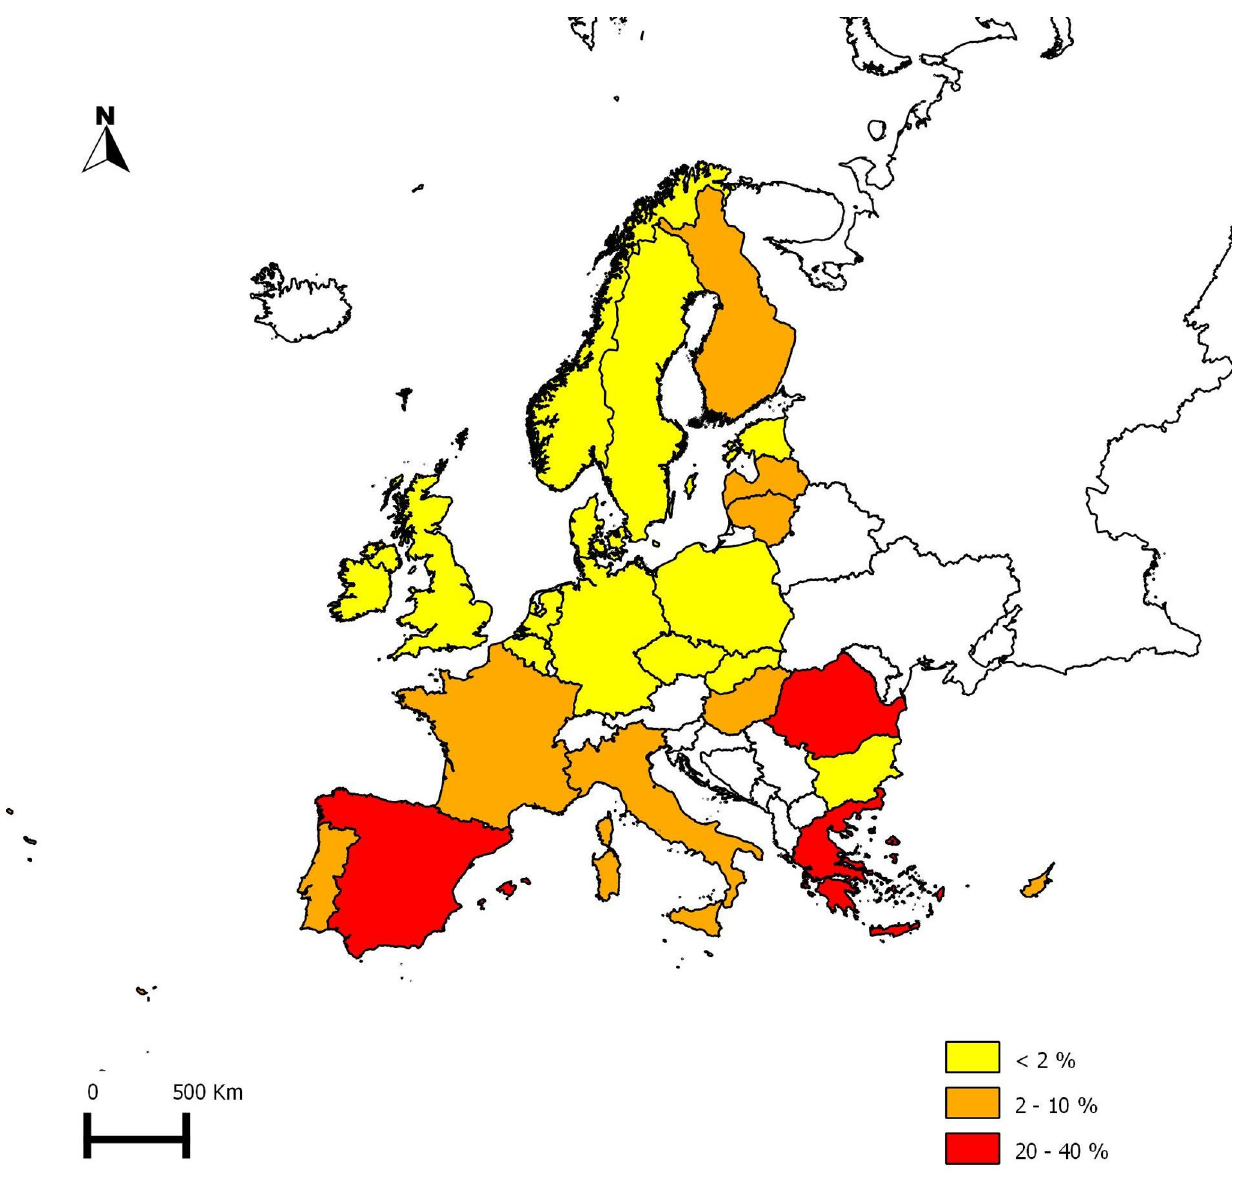
Figure 1. Percentage of professional beekeepers in Europe. Please see the text and Table 3 for the definition of ‘‘professional beekeepers’’. Data are presented according to the definition given by each country.